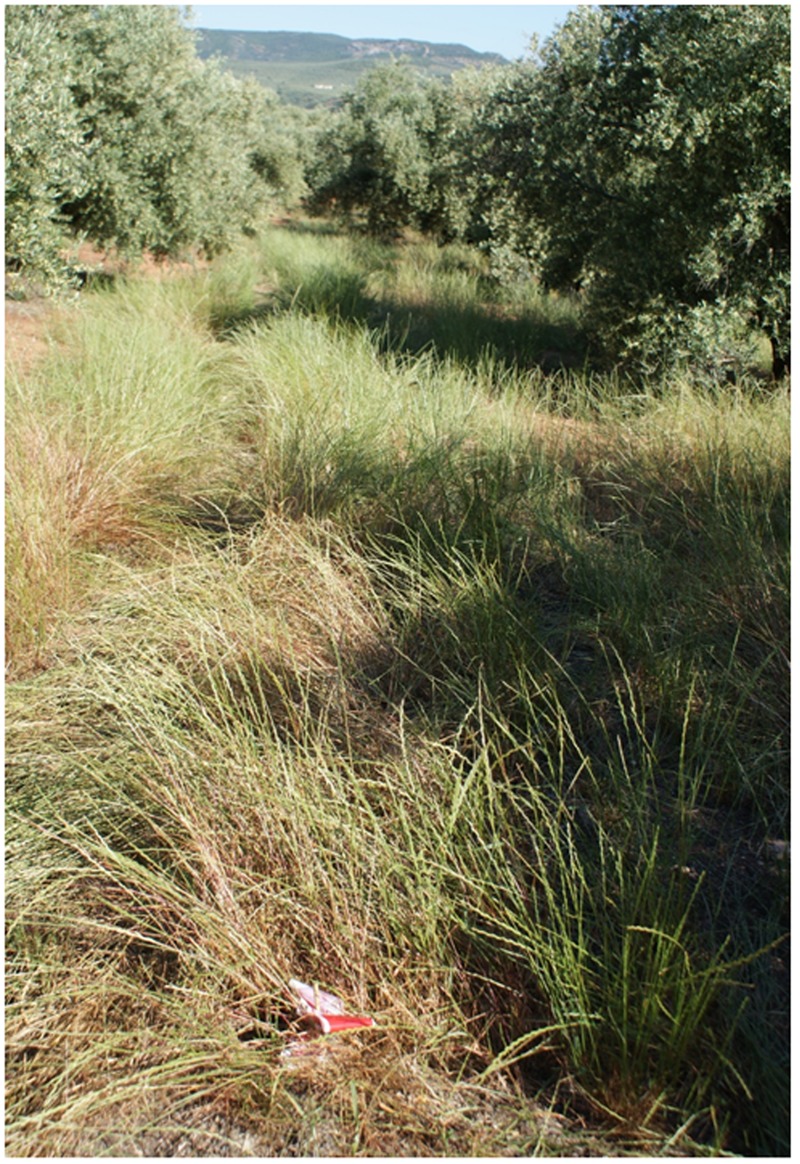
Rigid ryegrass treated with 1800 g ae ha-1 (grams of acid equivalent per hectare) of glyphosate at early post-emergence and measured 60 days after treatment.